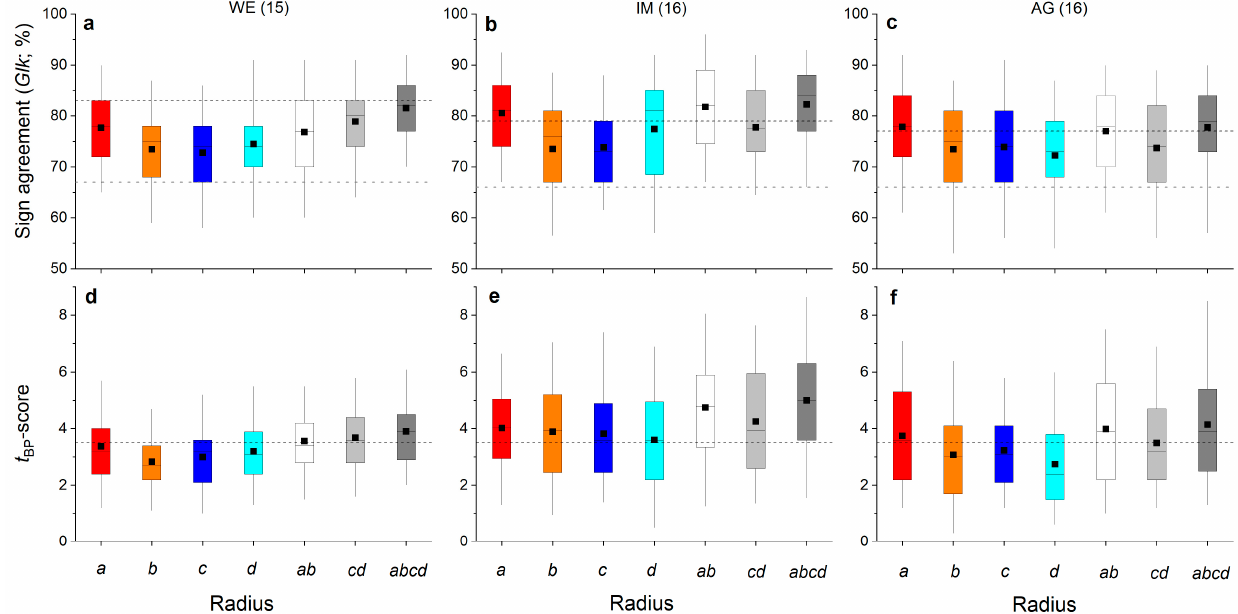
Figure 5. Box-plots showing variability in percentage of sign agreement (( a – c ); Glk = Gleichläufigkeit; Eckstein and Bauch 1973) and t BP -score (( d – f ); Baillie and Pilcher 1990) among single radii (i.e., a , b , c and d ), means of opposite radii (i.e., ab and cd ) and mean of all radii (i.e., abcd ) of shoots taken from one stock at a wind-exposed ridge (site WE), an intermediate site (IM) and a north-facing avalanche gully (site AG). Number of shoots measured per stock are given in brackets. In ( a – c ), horizontal dashed black and grey lines indicate the signi fi cance level of p ≤ 0.001 and p ≤ 0.05, respectively. In ( d – f ), the horizontal dashed black line indicates a t -value of 3.5 (see Material and Methods for details). For details on box-plots, see Figure 2.